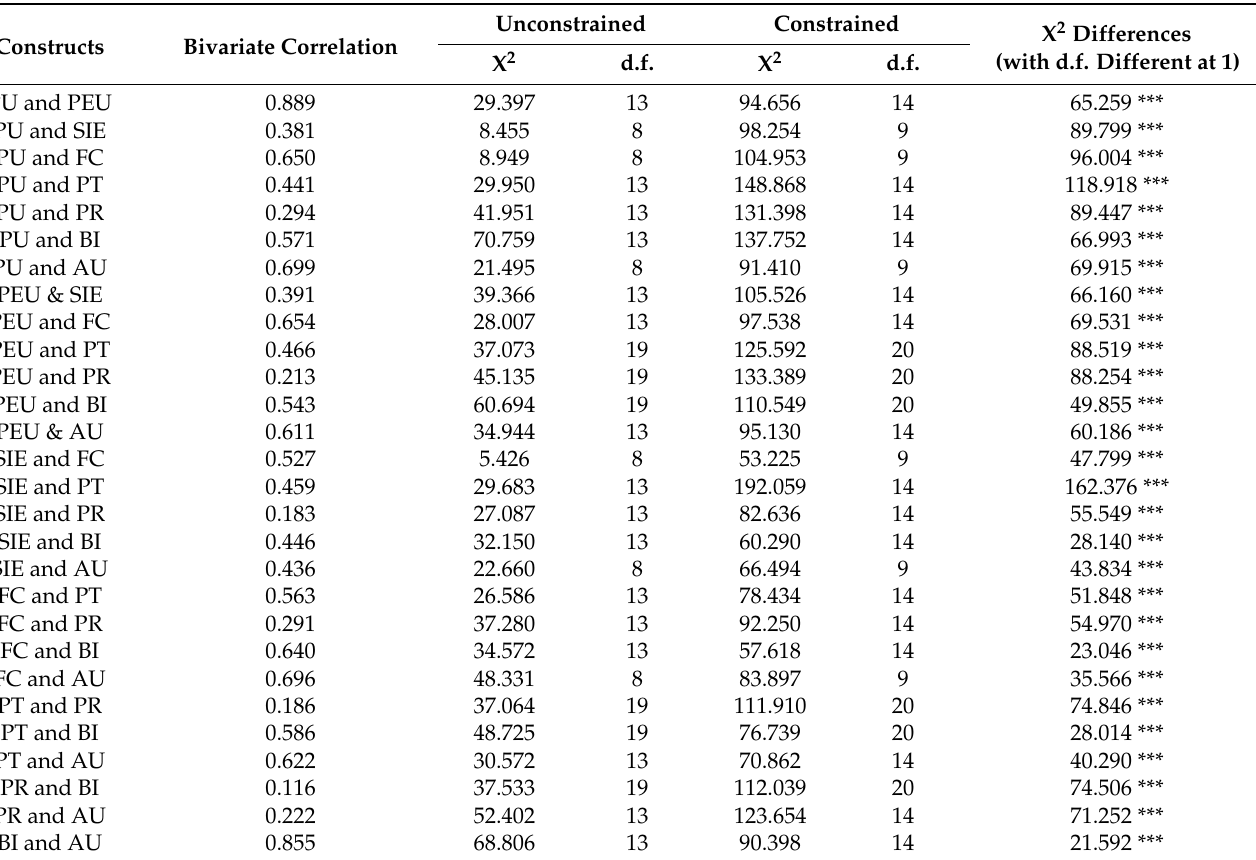
Table A3. Bivariate correlation and chi-square difference test. Notes that: ***— p < 0.001, constructs are different at the model